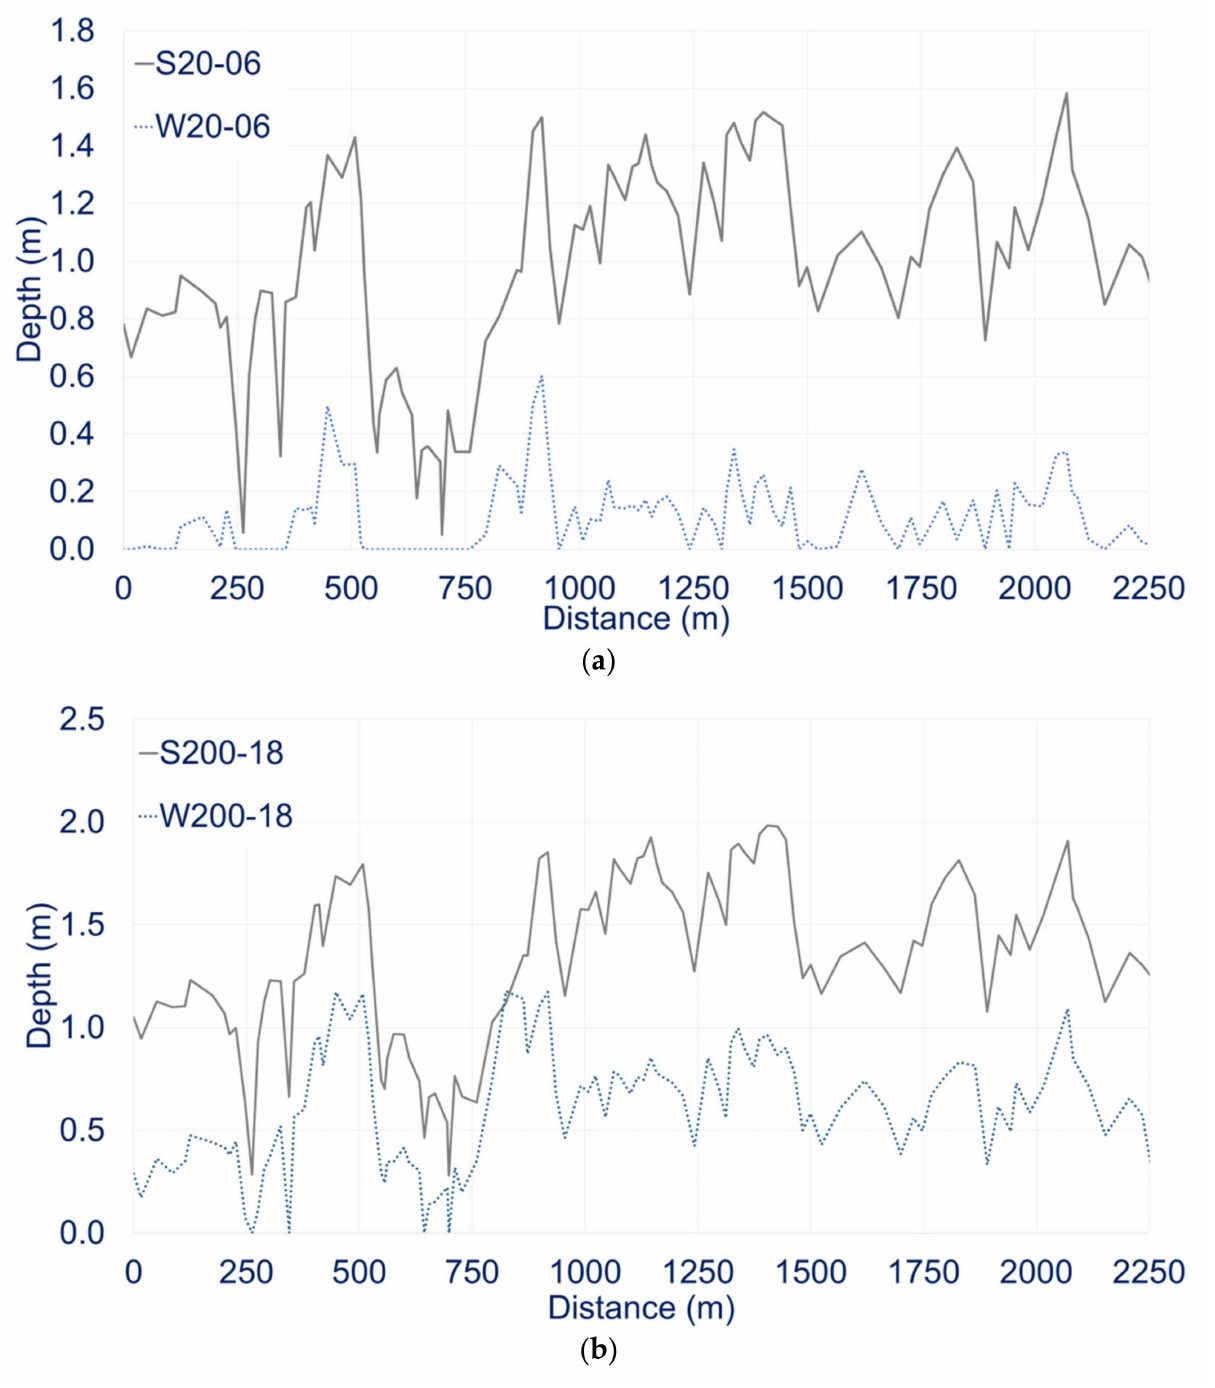
Figure 7. Maximum water depth along Koropouli Street for 4 indicative scenarios: ( a ) Scenarios S20-06 and W20-06 for T = 20 y and t = 6 h. ( b ) Scenarios S200-06 and W200-06 for T = 200 y and t = 18